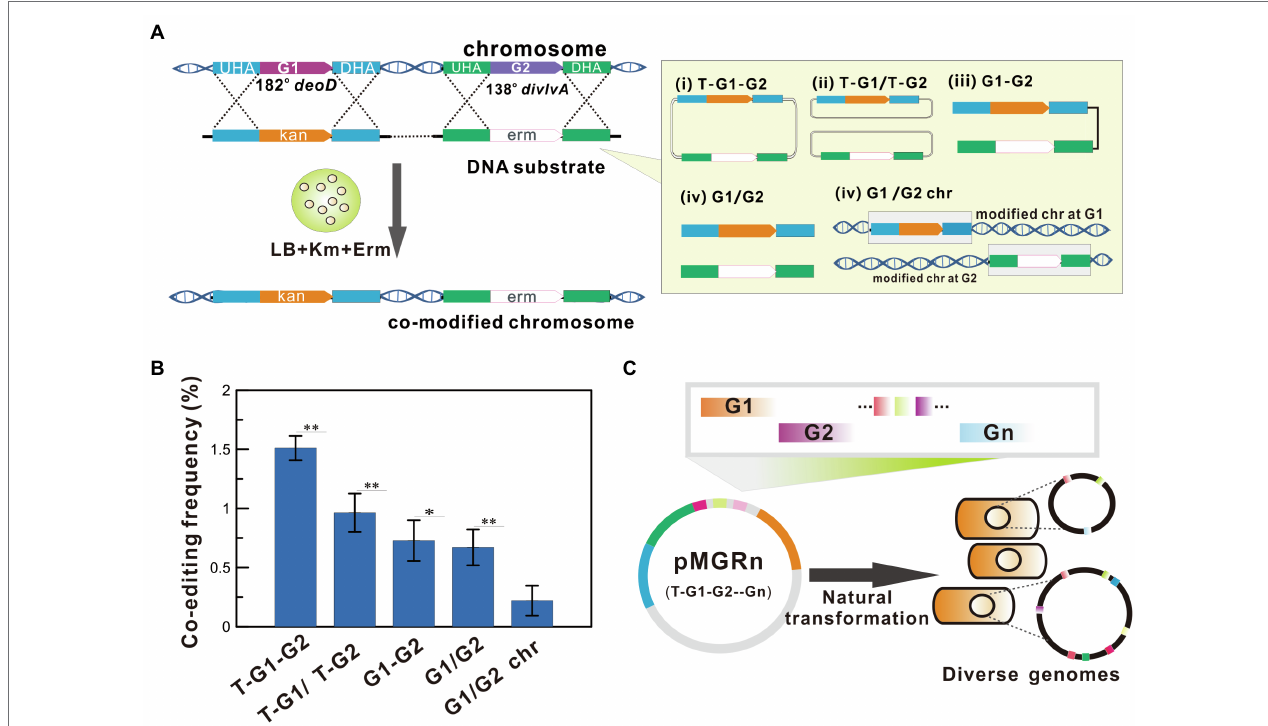
FIGURE 1 | Simultaneously Multiplex Genome Engineering (SMGE) using an all-in-one recombination vector. (A) Diagram showing the approach used to determine co-editing frequency of allele replacement at two distant locations using different DNA forms. The all-in-one recombination vector harboring two target genes (T-G1-G2), a mixture of two different recombination vectors for each target gene (T-G1/T-G2), an all-in-one PCR product for two target genes (G1-G2), a mixture of two PCR products for each target gene (G1/G2), and a mixture of chromosomal DNA separately harboring integration of an antibiotic gene at the G1 or G2 site (G1/G2 chr) were used (see details in the Supplementary Materials ). Luria-Bertani (LB) plates containing kanamycin or erythromycin were used to directly screen the single and double mutants. (B) The effects of different DNA construct on the co-editing frequency. All error bars indicate ± SD, n = 3. A value of P less than 0.05 was regarded to be a significant difference using the T -test ( * p < 0.05; ** p < 0.01). (C) A schematic illustration of SMGE using an all-in-one vector harboring multi- gene recombination modules (pMGRn). G represents the targeted genetic